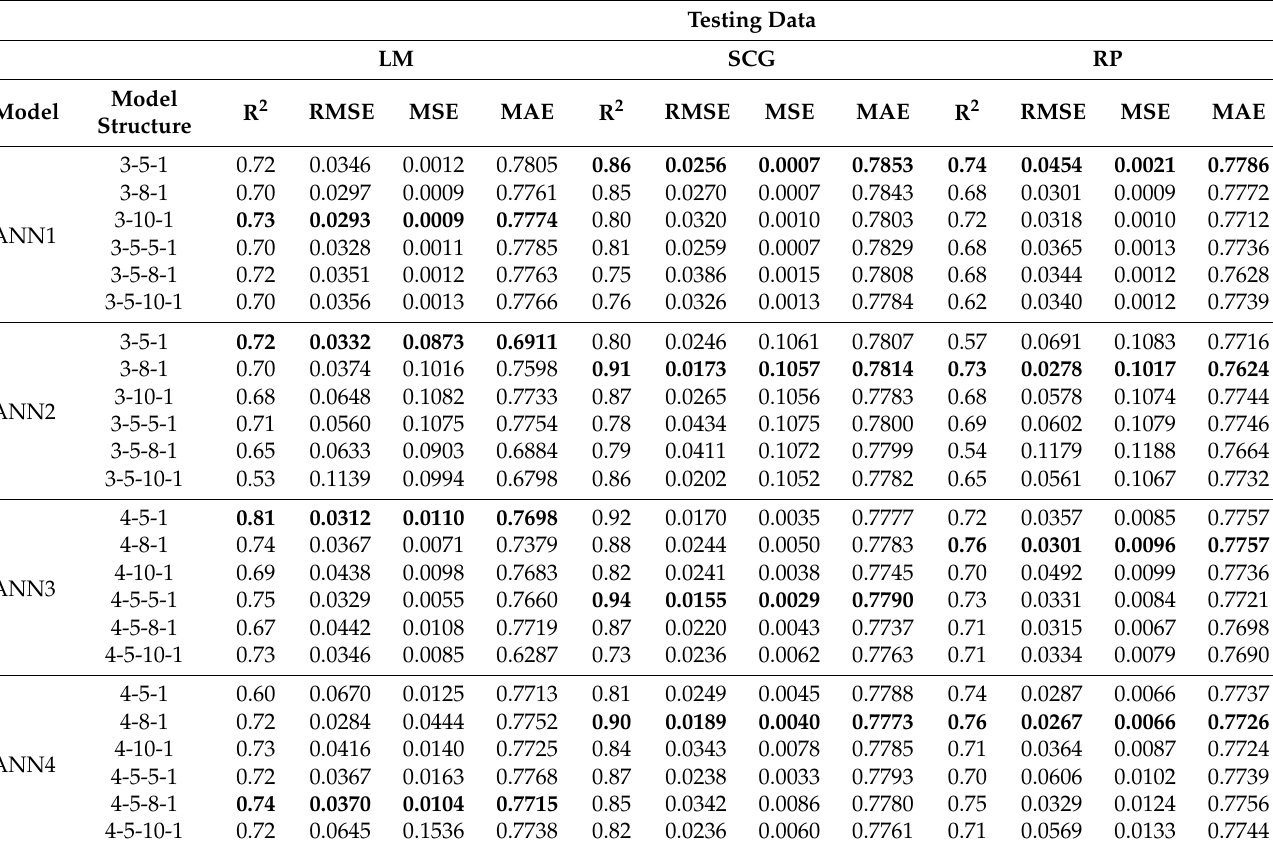
Table 4. Statistical results between calculated and predicted rupture energy in testing data by the developed ANN